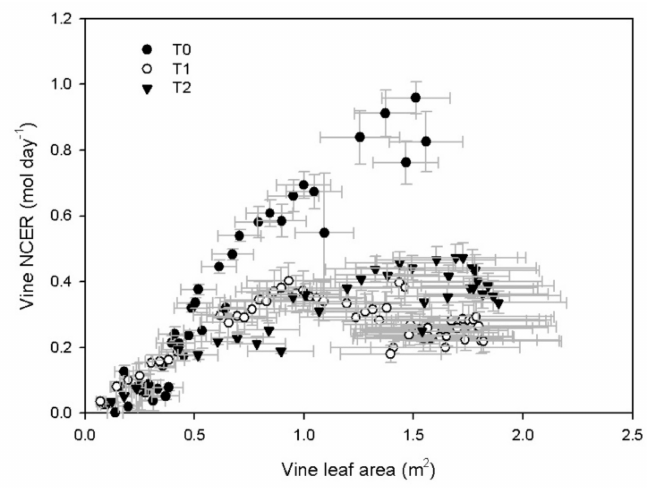
Figure 6. Vine net CO 2 exchange rate (NCER) from budburst to shoot topping vs. vine leaf area in T0, T1, and T2 vines ( n = 4). Mean ± SE. In T1 and T2 treatments, further leaf area development did not increase vine NCER.